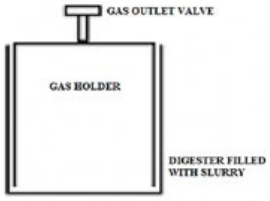
Fig. 1: Floating drum digester (drum in drum type) of 3.5 L capacity